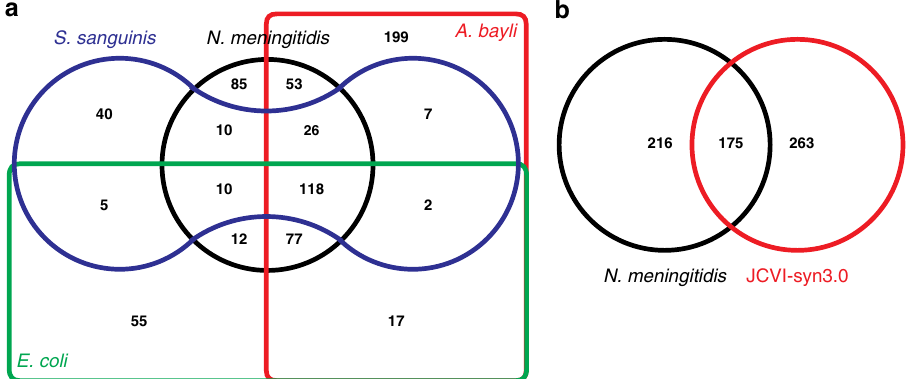
Fig. 3 Comparison of N. meningitidis essential genome to that of other bacteria. a Edwards – Venn diagram displaying overlaps between essential genes in bacteria in which complete libraries of mutants have been constructed: N. meningitidis (black line), E. coli (green line) 10 , A. baylyi (red line) 12 and S. sanguinis (blue line) 13 . To perform this analysis, we queried the DEG database 65 of essential genes using our set of essential genes. The corresponding datasets are listed in Supplementary Data 6. b Comparison of N. meningitidis essential genome (black line) to JCVI-syn3.0 (red line), a synthetic M. mycoides designed with a minimal genome 22 . The corresponding datasets are listed in Supplementary Data